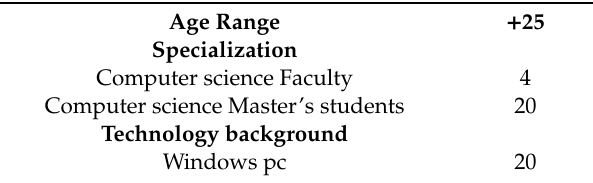
Table 1. A summary of participants’ demographics.